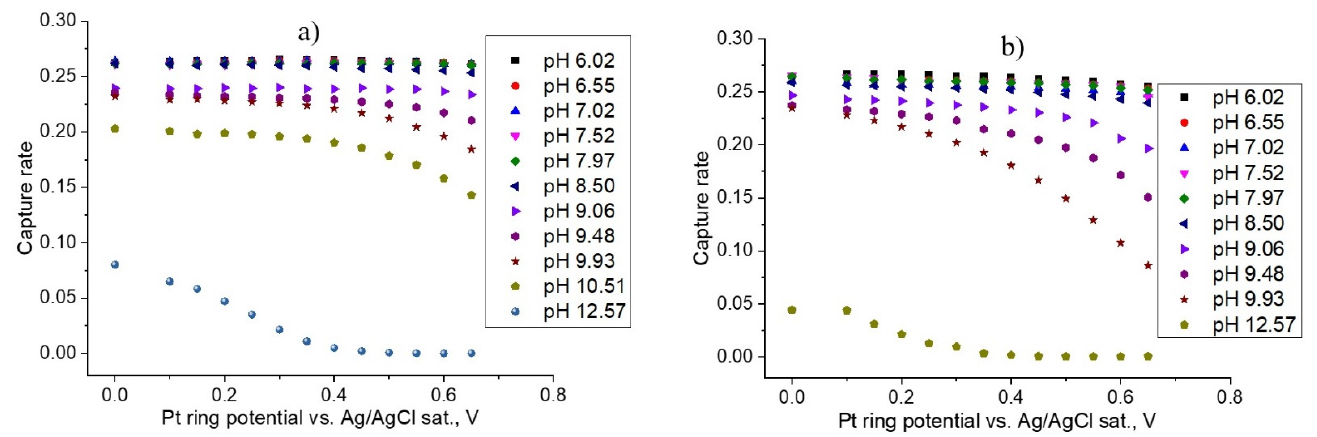
Figure 7. Ring collection efficiencies on the Pt ring under the applied 10 mA on the GC disk for 0.5 M NaBr solutions at different pH levels. The graphs are presented for two rotation rates of the RRDE: ( a ) 200 rpm and ( b ) 5000 rpm.